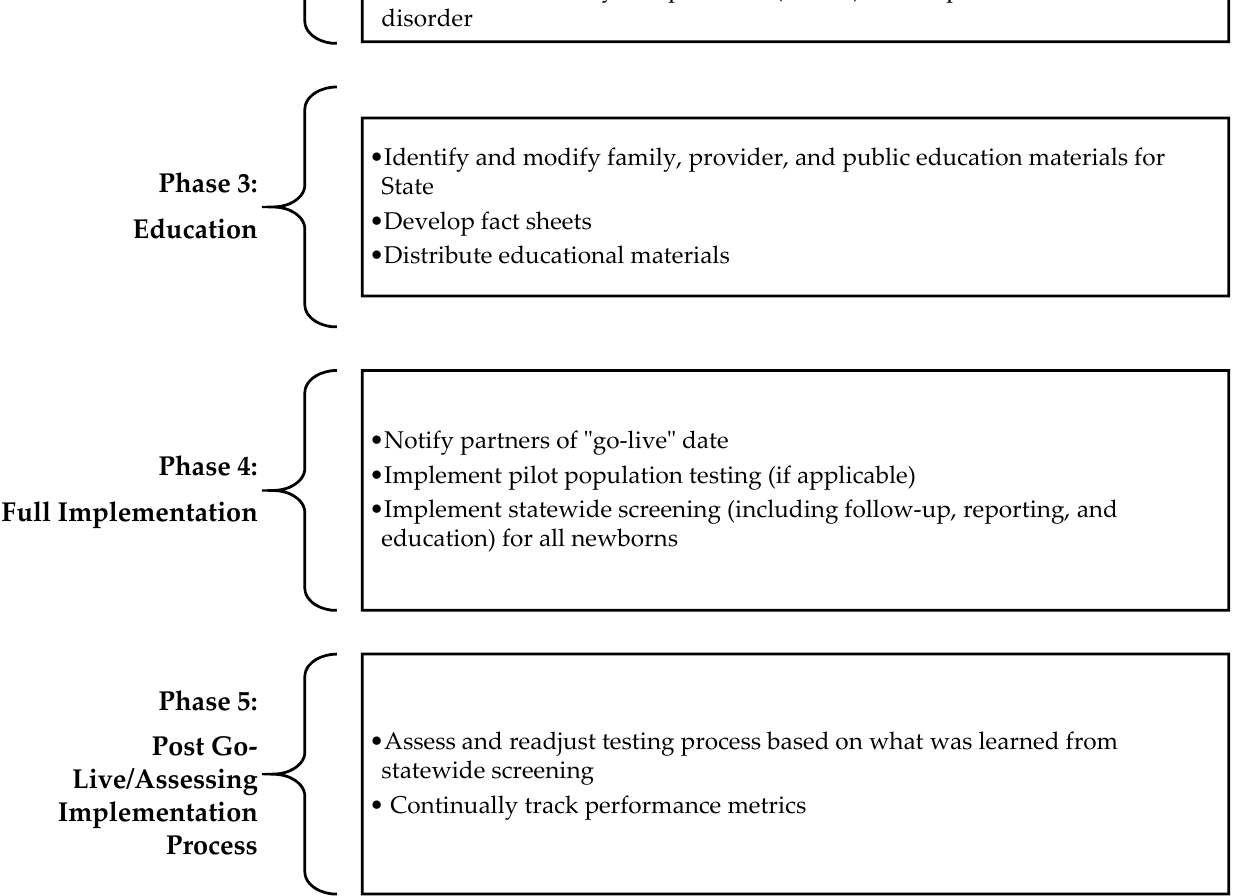
Figure 1. Phases of implementation for new disorders in newborn screening [13].